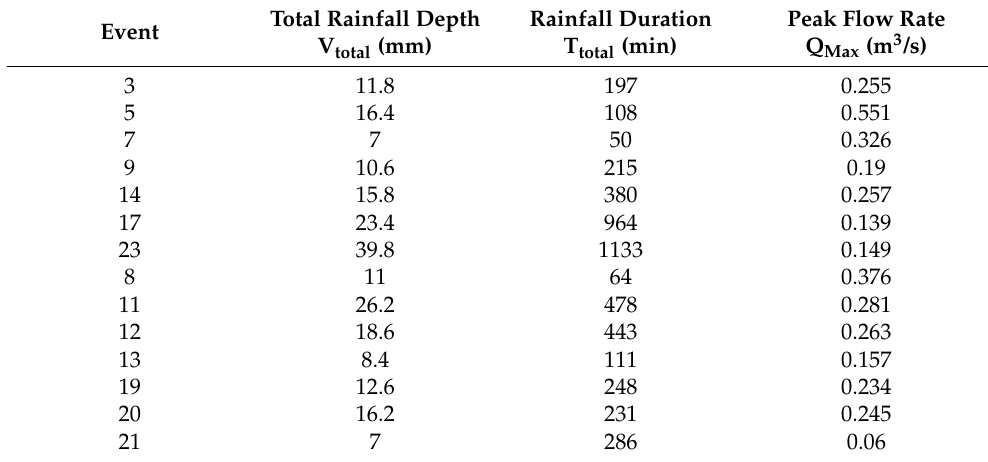
Table 2. Main characteristic of the selected rainfall events. The first seven events are for calibration. The following seven events are for